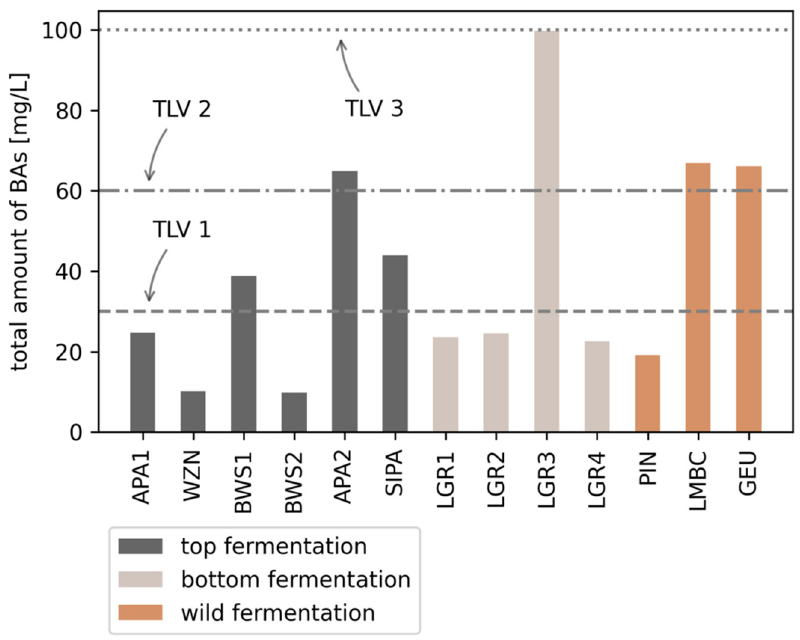
Figure 2. Total amount of BAs [mg/L] expressed as sum of 14 BAs ( ∑ MA, EA, DMA, PA, AGM, BUA, PUT, TRP, FEA, HIS, CAD, SPD, TYR, SPE) in 13 different beer samples. TLV 1 (threshold limit value)–risk for consumers with ineffective detoxification mechanism: 30 mg/L; TLV 2–risk for all consumers: 60 mg/L; TLV 3–general BAs threshold for foods: 100 mg/L).